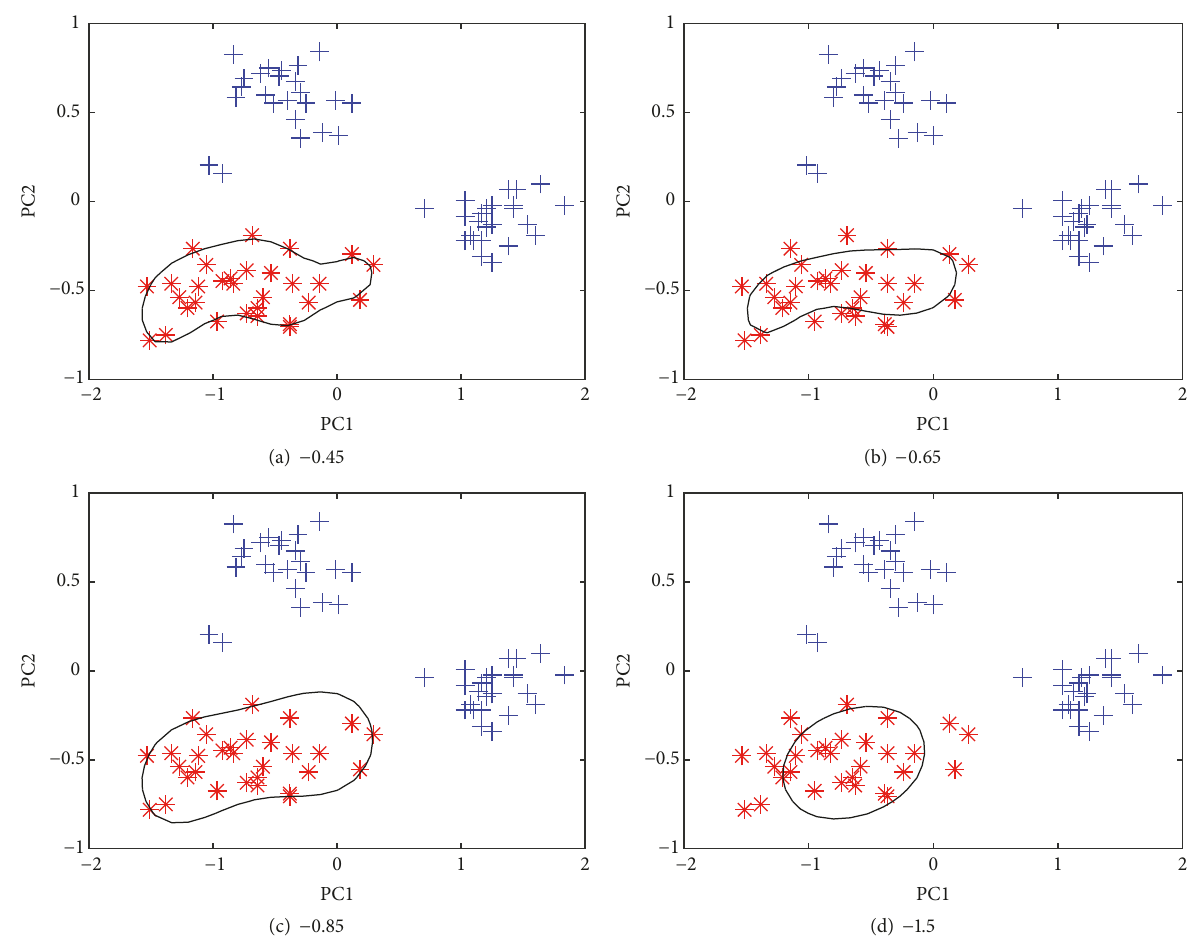
Figure 5: The influence of the kernel parameter on the boundary of support vector data description (SVDD) using class A as the target class (classification error on the target class is set as